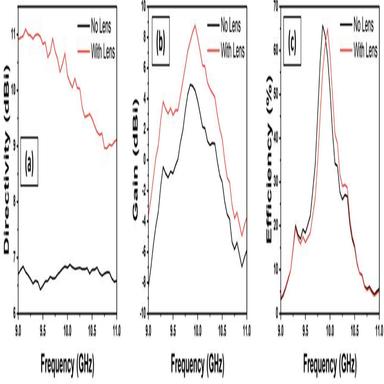
Measured antenna results (a) Antenna Directivity, (b) Antenna Gain and (c) Total Efficiency of the antenna with/without the 3D printed hemispherical lens.